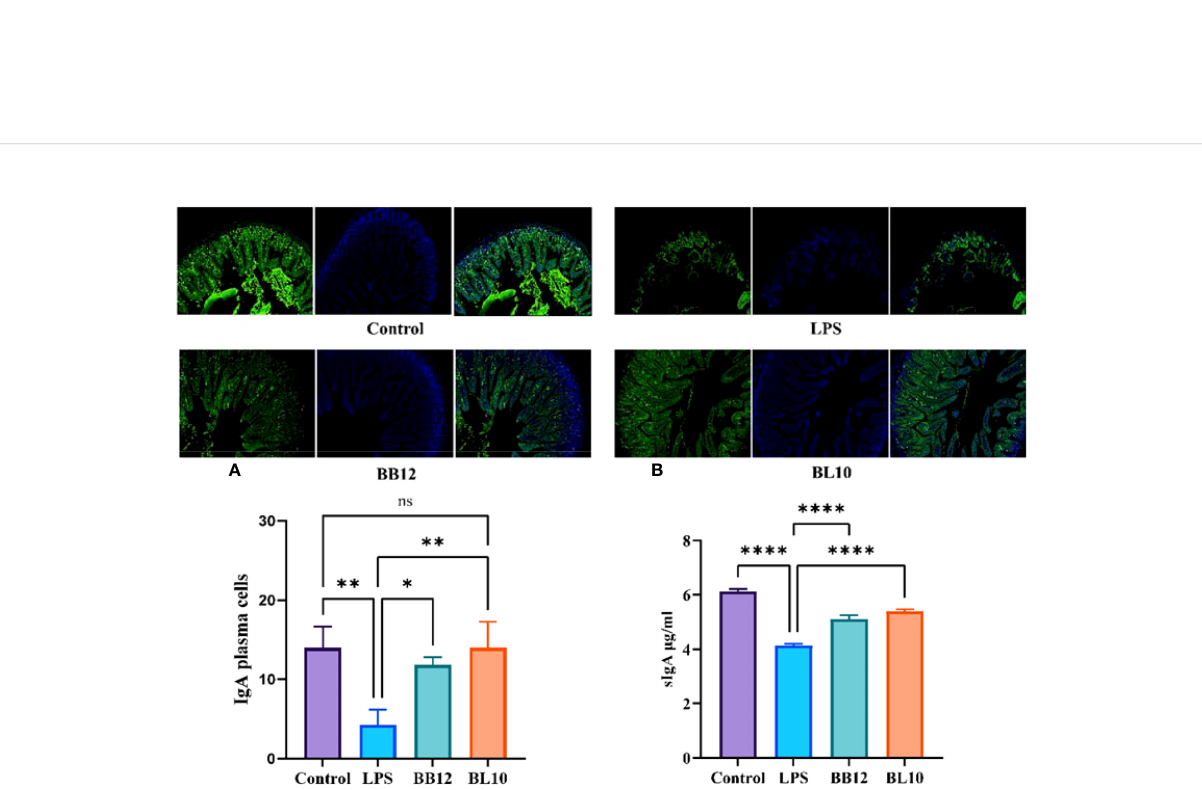
FIGURE 4 Effect of B longum BL-10 on ileal IgA plasma cells. (A) IgA plasma cells; (B) sIgA level. All data are expressed as mean ± SD (n=3). Values with a different superscript letter (*, **, **** and ns) were signi fi cantly different at p <0.05, p <0.01, p <0.0001 and p >0.05.